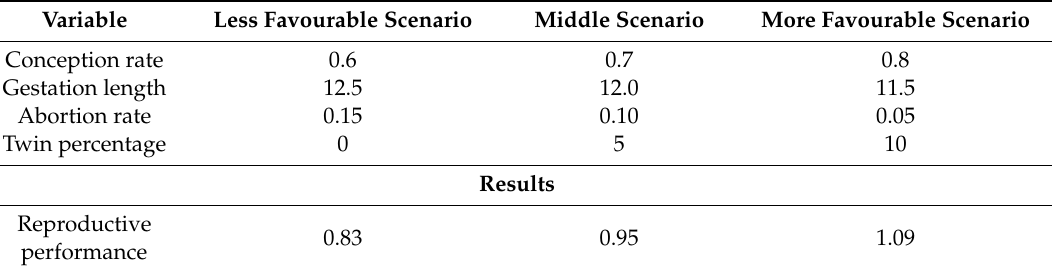
Table 1. Summary of the reproductive performance parameters and results.